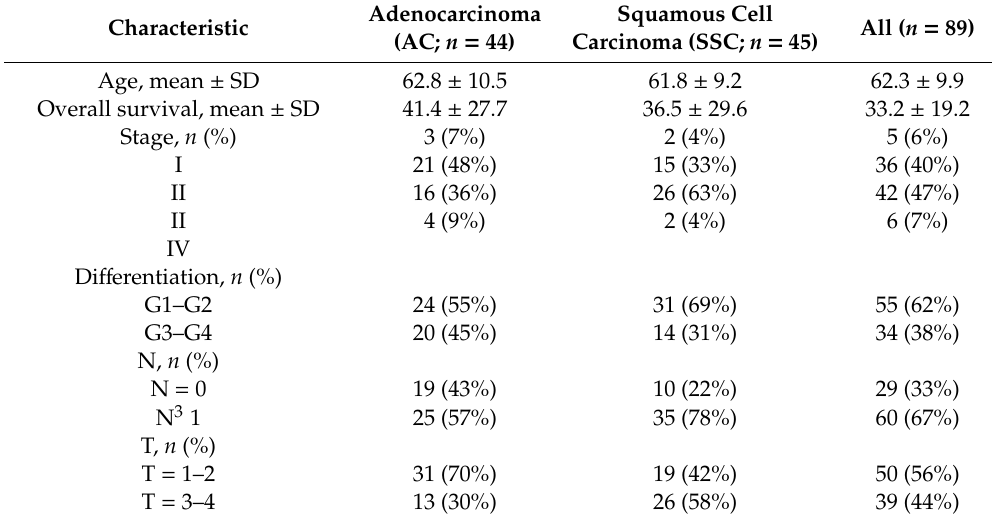
Table 1. Clinical characteristics of non-small cell lung cancer (NSCLC)